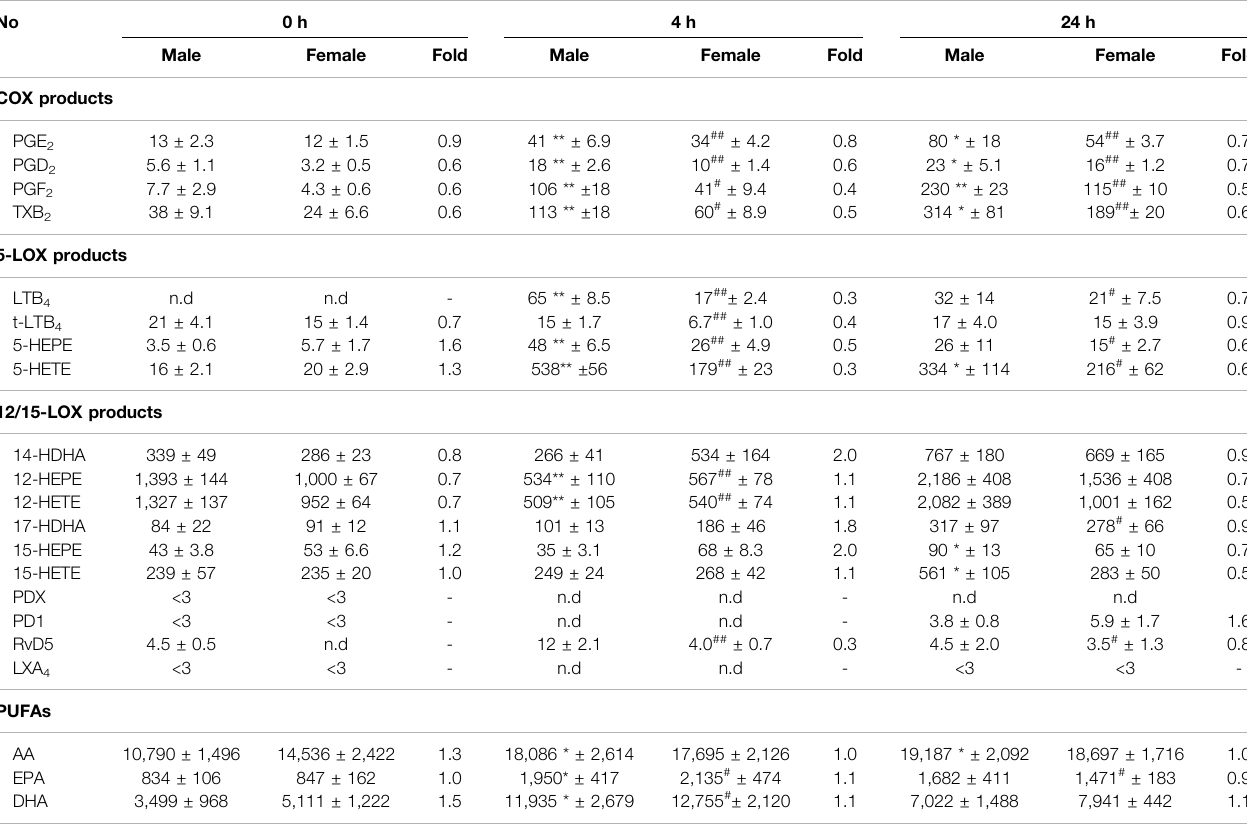
TABLE 1 | Lipid mediator pro fi ling in peritoneal exudates of male and female mice. Amounts of LM in peritoneal exudates from male and female mice taken at different time points post-zymosan/vehicle i.p. injection (see legends Figure 1 ). Data are given in pg/mL exudate expressed as mean ± SEM of n (cid:1) 5 to 6 animals per group and as heatmap.Fold-changeoffemalemeanvaluescomparedtomalemeanvalues.* p < 0.05,** p < 0.01male0 hvs.Fouror24h;# p < 0.05,## p < 0.01female0 hvs.Fouror24 h; unpaired Student ’ s t